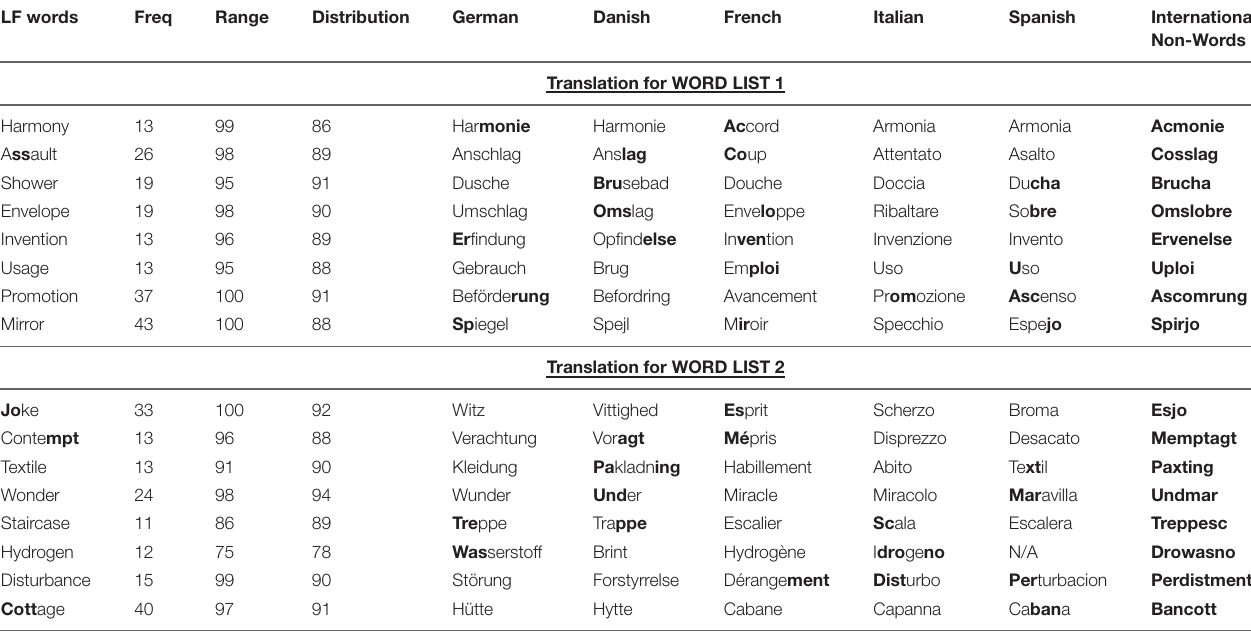
TABLE 1 | Translation of the low frequency words and aggregation of word fragments (underlined) into international non-words